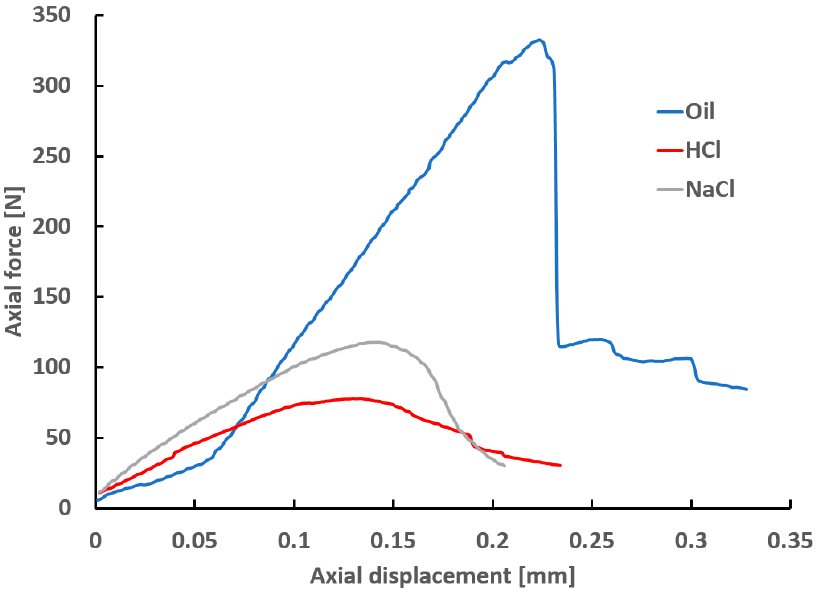
Figure 3. Typical force-displacement curves obtained after 96 h of exposure to different fluids i.e., oil, 1M NaCl brine and 1M HCl. Indicate decimals with “.” not “,”